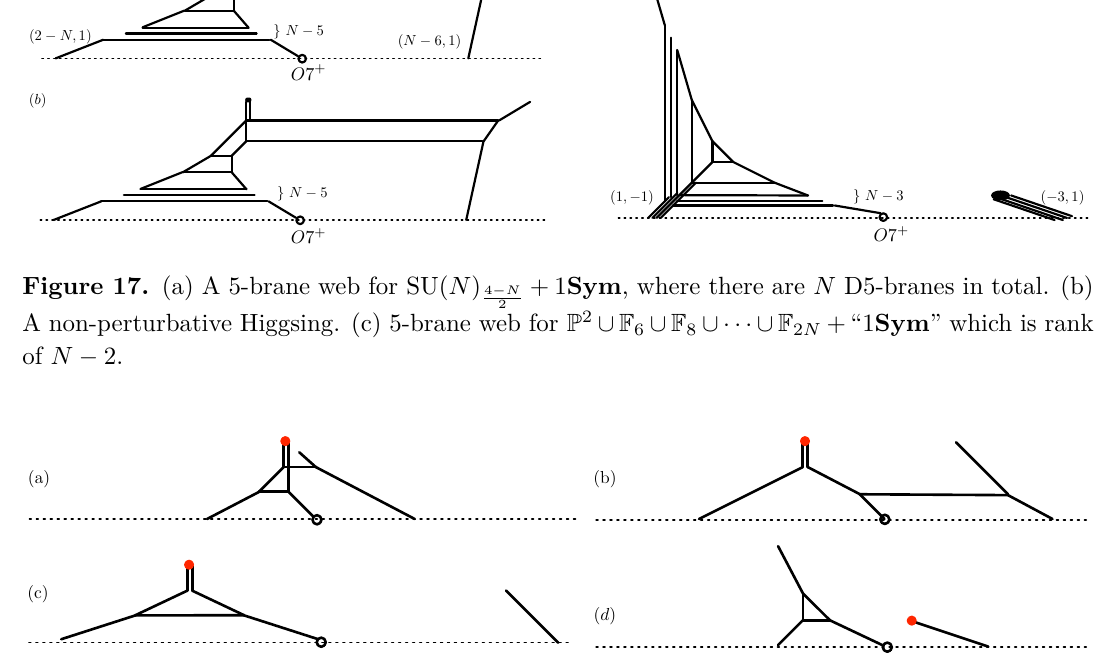
Figure 18. Various phases of 5-brane web for local P 2 + “1 Adj